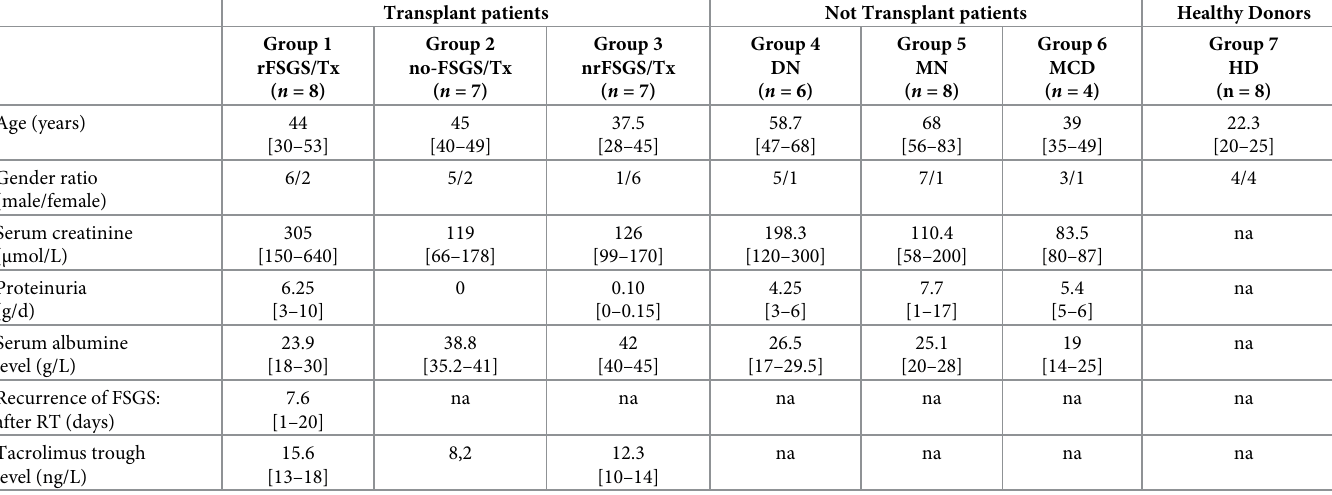
Table 2. Clinical and biological characteristics of patients in the different